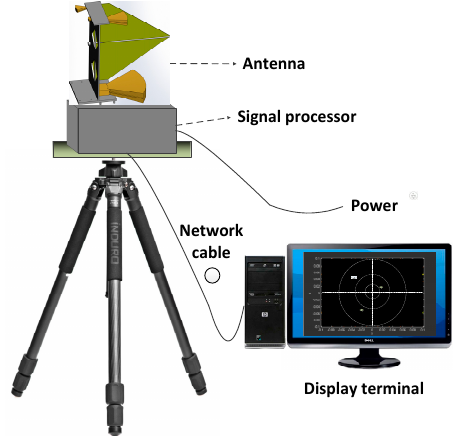
Figure 10. Diagram of signal transmitting system structure.